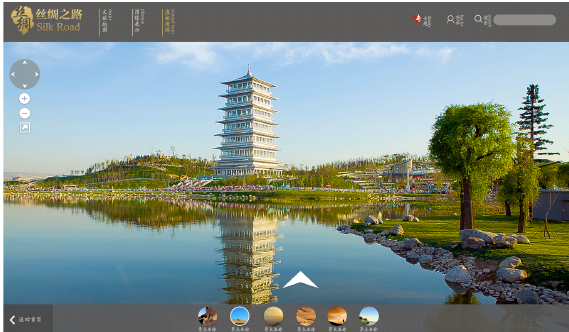
Figure 6: Example on interface design for Three-dimensional virtual tour of the website